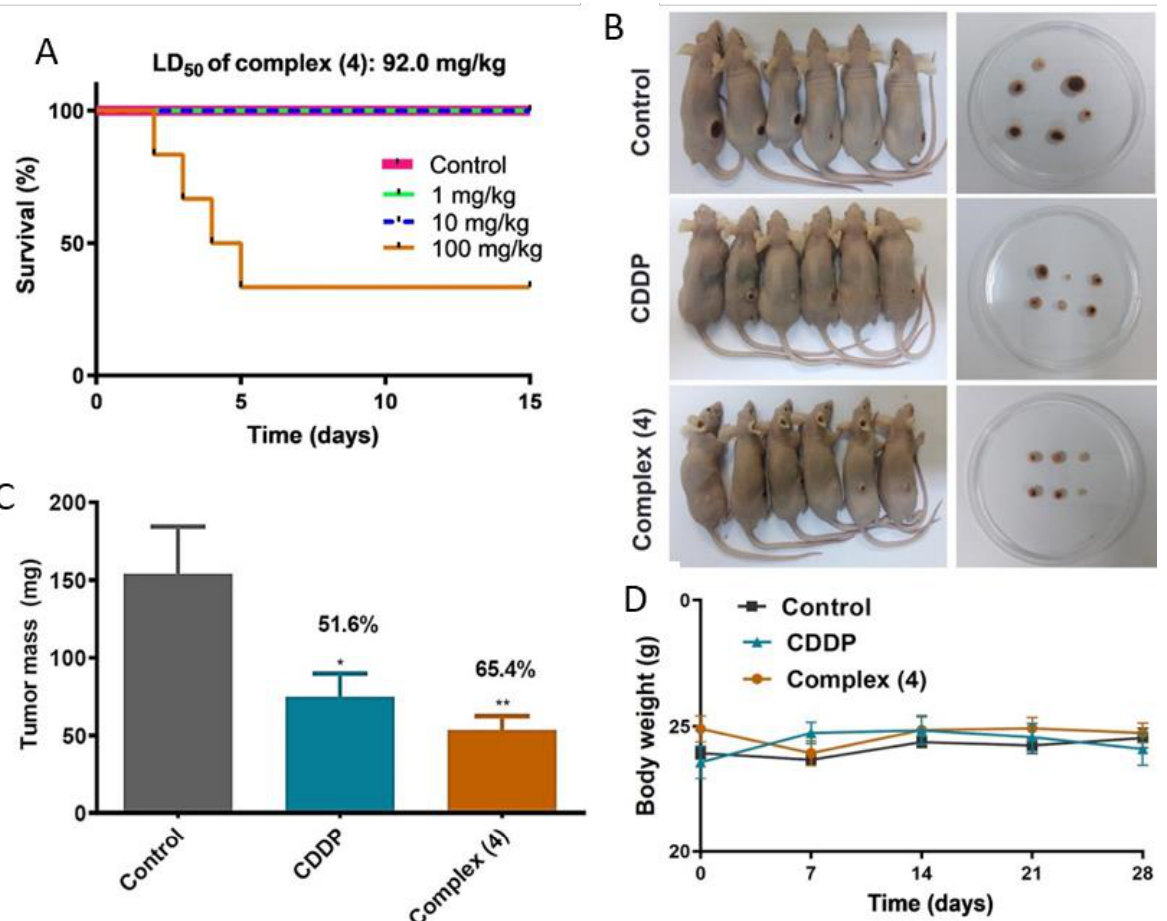
Figure 7. In vivo efficacy of complex ( 4 ) in the tumor growth inhibition in Balb/c nude mice bearing MDA-MB-231 breast tumors ( n = 6 in each group). Animals were treated i.p. with 50% of the LD 50 of complex ( 4 ) (46 mg/kg) or cisplatin (3.3 mg/kg) in four doses at 1 week intervals. ( A ) Determination of acute lethal dose; ( B ) animals and dissected tumor nodules; ( C ) mean total weight of the dissected tumors after the end of treatment; ( D ) body weight loss curves during the treatments. Data were analyzed by ANOVA/Bonferroni and expressed as the mean ± SD; a significant difference was taken as * p < 0.05 and ** p < 0.01 when comparing the treated and control groups.